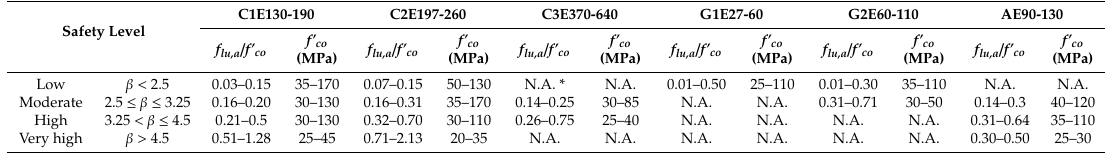
Table 5. Confinement ratio and unconfined concrete strength ranges for different safety levels of the current database of FRP-confined concrete using two ultimate failure modes.